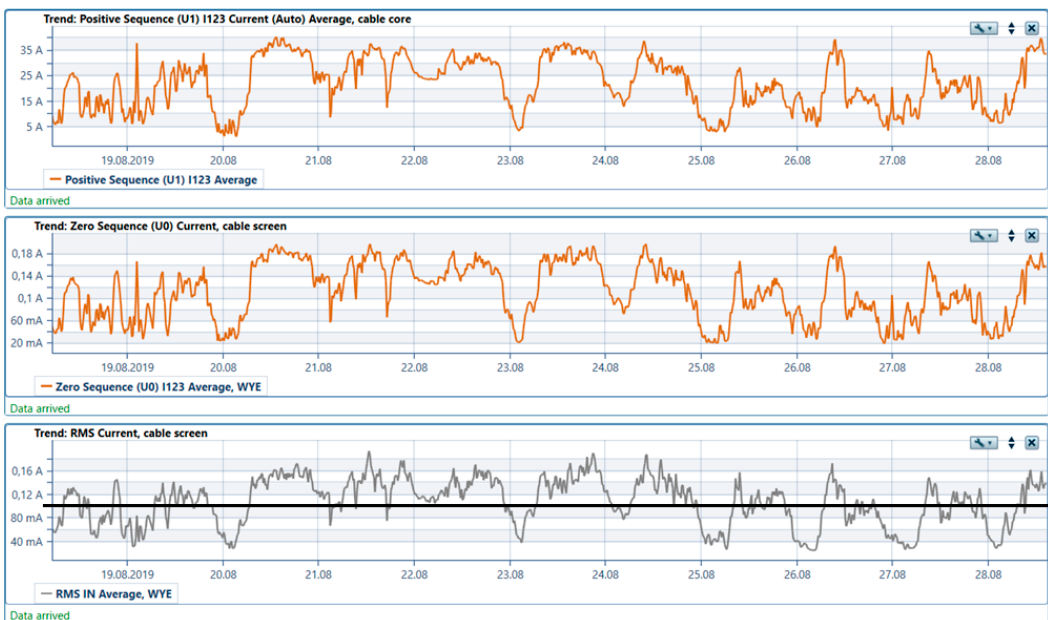
Figure 16. Criterion values used in the presented algorithm: positive sequence load current (first from above), digitally calculated zero-sequence current (in the middle) and residual earthing screen current— I rcs (at the bottom).